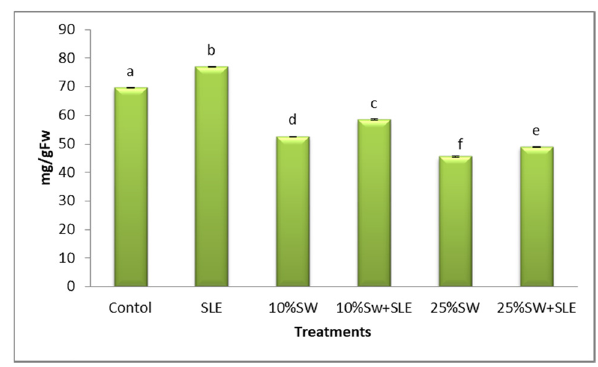
Figure 4: E ff ect of 2% SLE in carbohydrate contents of T. aestivum L. grown under salt stress. Control – tap water, SW – seawater, SLE – spirulina liquid extracts 2%. The di ff erent letters are signi fi - cant ( P ≤ 0.05 ) according to Duncan ’ s multiple range tests. plant was observed under salinity treatments ( 10% and 25% SW ) . The conjugation e ff ect of seawater and SLE preparations leads to a di ff erent increase in protein sto - rage with seawater supplementation. The results obtained in Figure 5 demonstrated that the 2% SLE promoted the protein contents of T. aestivum more than the protein con - tents in control. The increase in protein content of T. aestivum exits after treatment with S. platensis extract, which indi - cates that S. platensis extract may contain substances that cause this increase. According to reports, S. platensis extract contains amino acids and zinc [ 25 ] . The highest protein, total carbohydrate contents, phenols, and antiox - idant of T. aestivum were observed at a concentration of SLE of S. platensis ( 2% ) . There was such an increase in protein, amino acid, and total carbohydrate contents. Foliar applied S. platensis reduced adverse e ff ects of sali - nity by improving the total protein level, N, P, K, and photosynthetic activity of V. faba L. [ 25 ] .